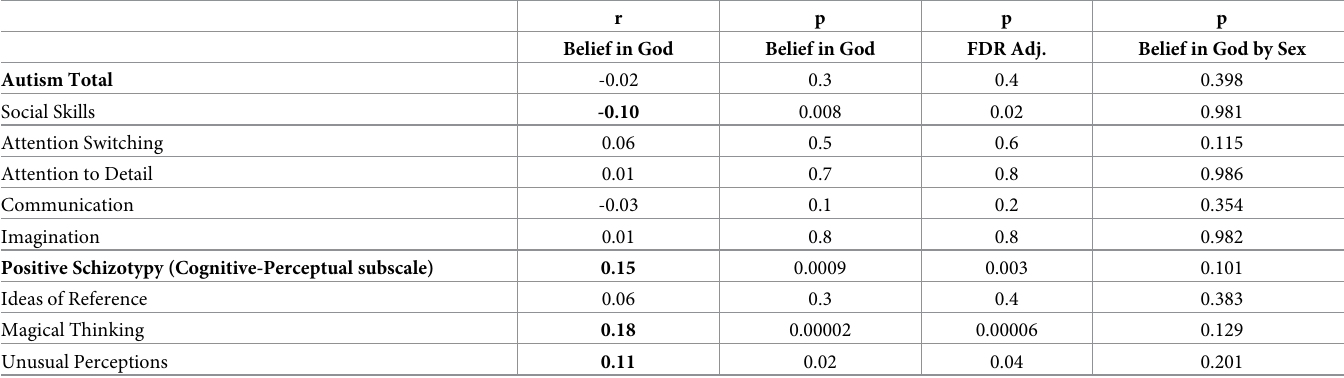
Table 3. Correlations of belief in god with autism and schizotypal traits, and results from ANCOVAs testing for sex by trait interaction effects.